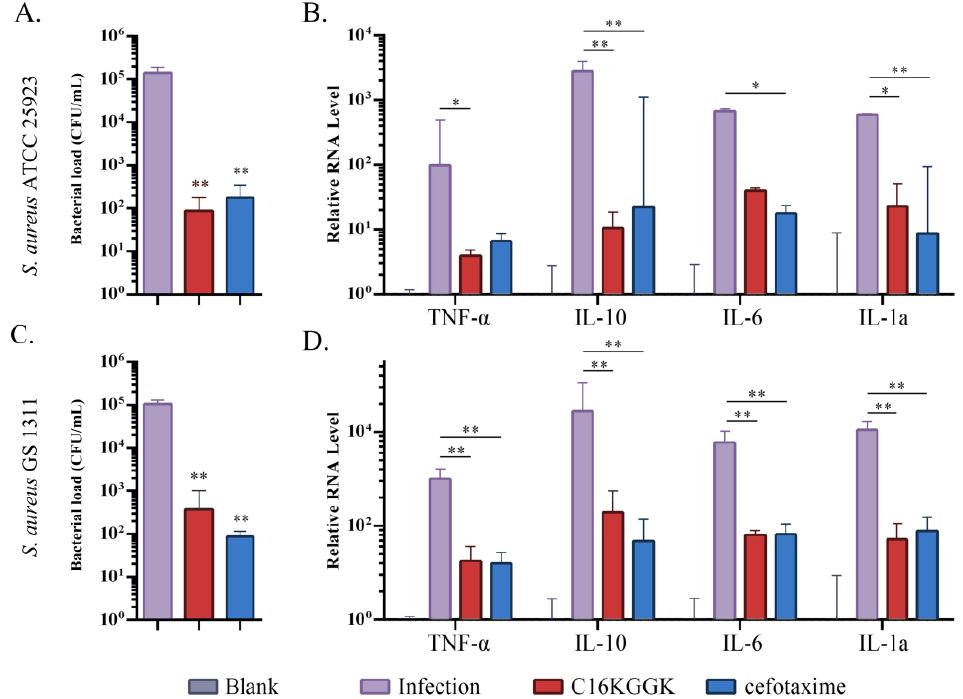
Figure 6. Quantitative determination of changes in mammary gland tissue of the mice. ( A, C ) Intra-tissue bactericidal effect of SLPs on mastitis caused by S. aureus . ( B , D ) Expression of inflammatory factors in mammary tissue of mice before and after SLPs treatment (“*”: p < 0.01; “**”: p < 0.001).